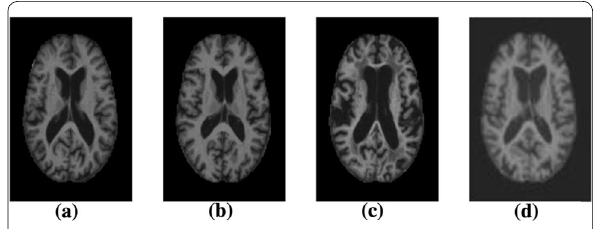
Fig. 1 Example of different brain MRI images presenting different Alzheimer’s disease stages. a Non-demented; b Very mild dementia; c Mild dementia; d Moderate